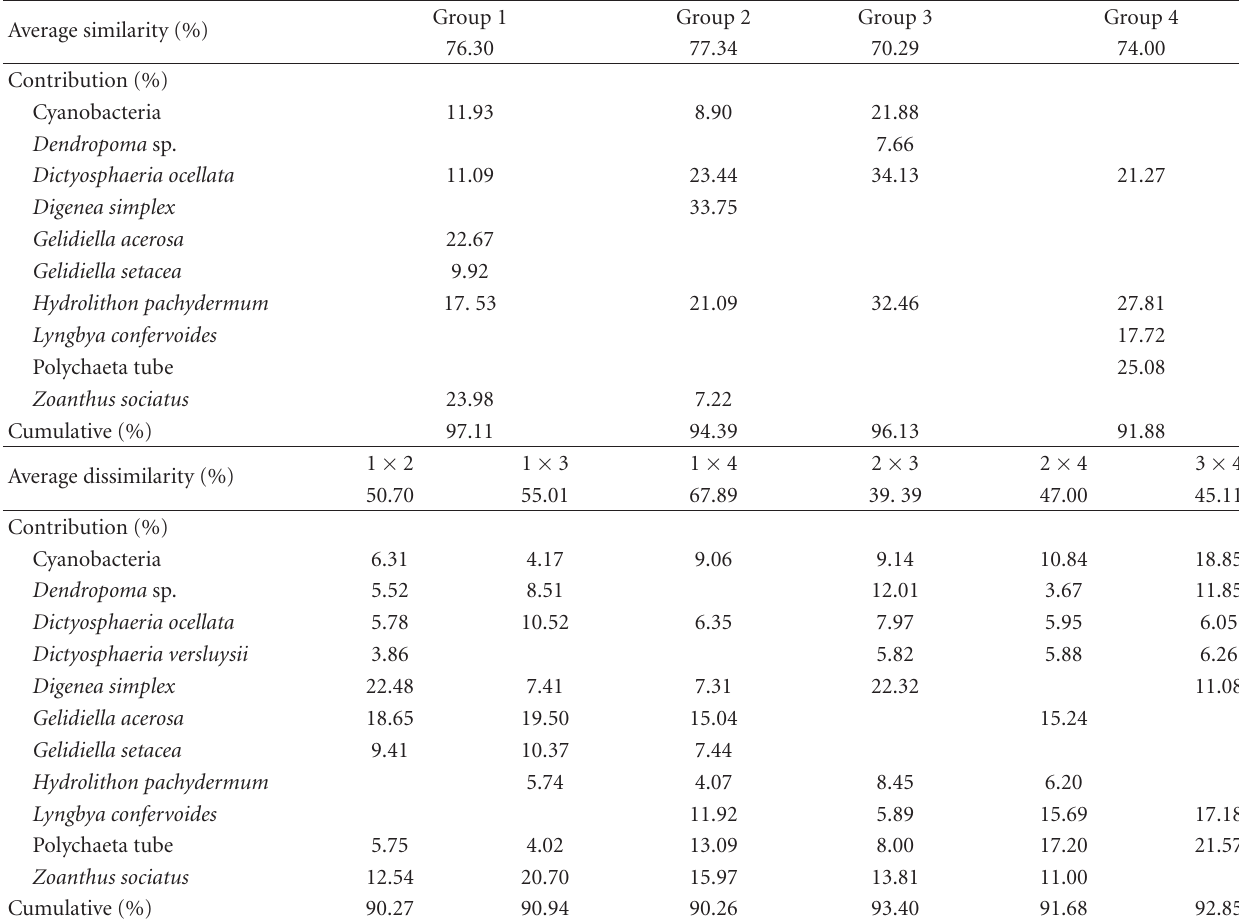
Table 4: Summary results of SIMPER show the percentage contribution of species for the similarity into the groups of station and the dissimilarities within them. Bold type values correspond to species with more than 15%